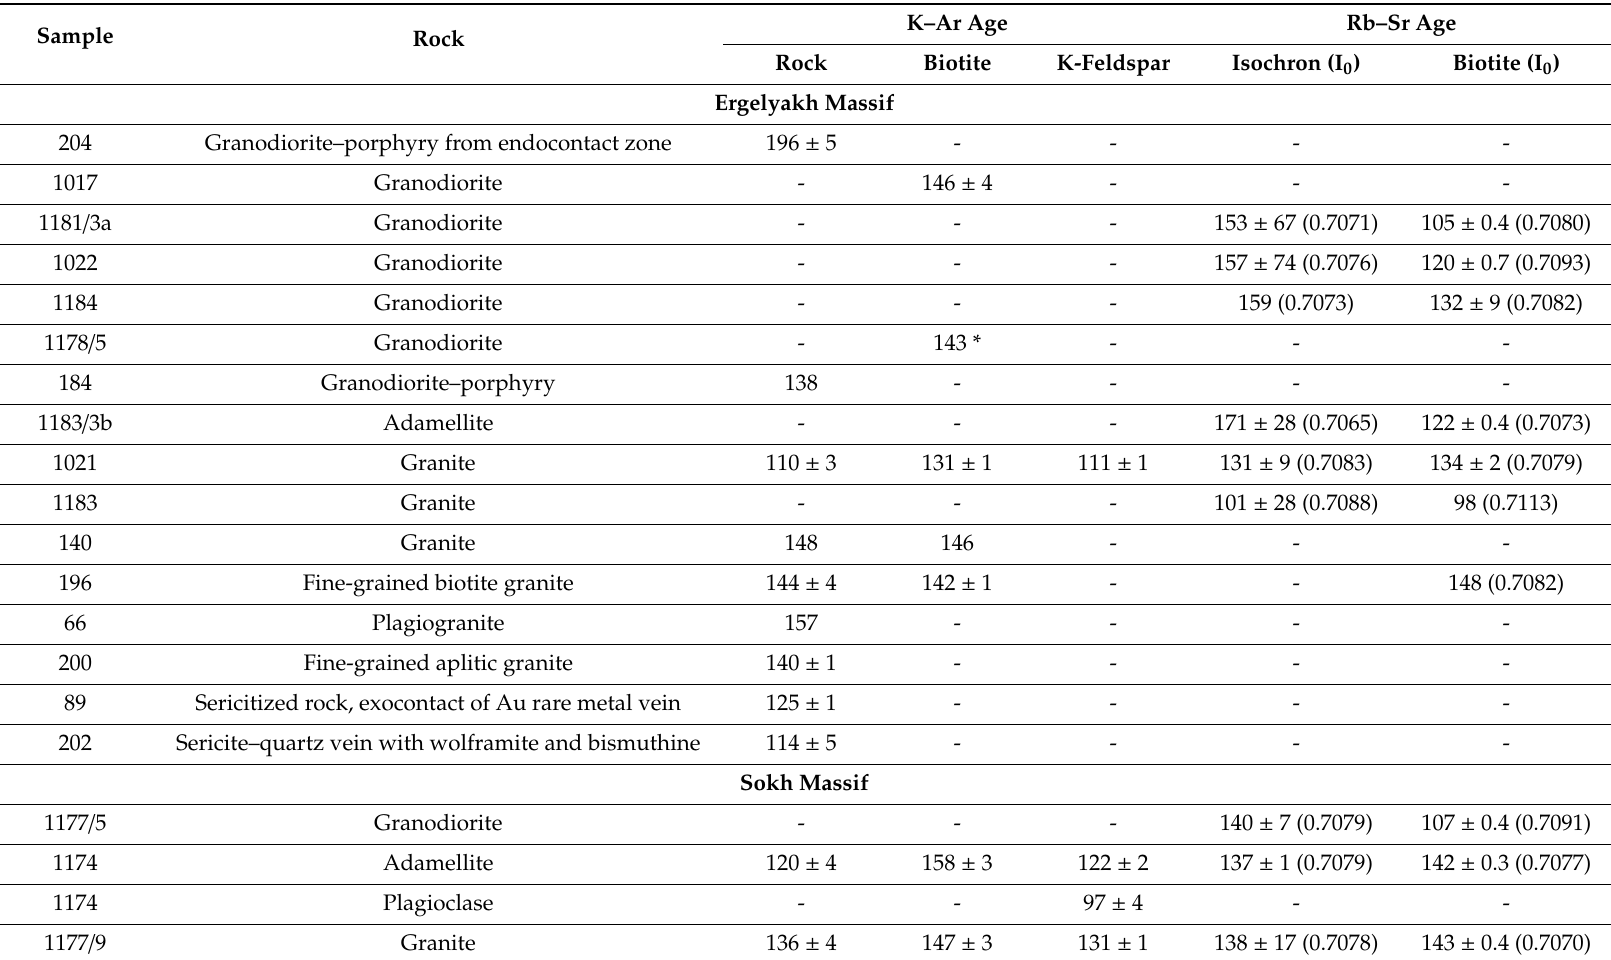
Table 6. Results of isotopic dating of granitoids of Ergelyakh intrusion-related gold–bismuth